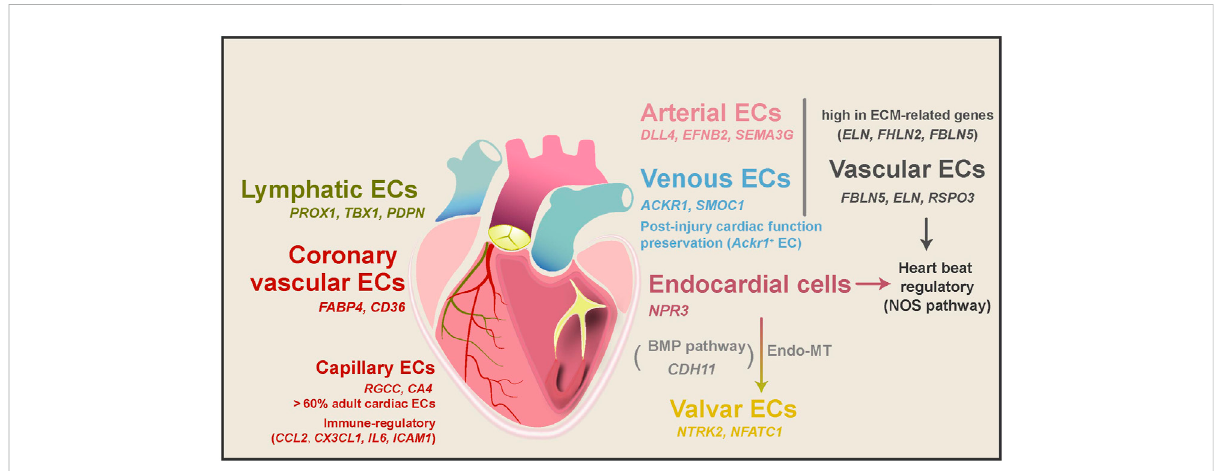
FIGURE 4 EC subtypes, their transitions, and functions in heart development and diseases. ECs mainly consist of vascular ECs, lymphatic ECs, coronary vascular ECs, capillary ECs, endocardial ECs, and valvar ECs. These subtypes of ECs have different molecular characteristics and biological functions depending on their anatomical positions. Vascular ECs can be divided into arterial and venous ECs, and Ackr1+ venous ECs have been shown to prepare cardiac function after injury. Both vascular and endocardial ECs were speculated to regulate heartbeat through the NOS pathway. During heart development, parts of endocardial cells transform into valvar cells through the endo-MT process. Capillary ECs are also potential regulators of immune responses in the healthy adult human